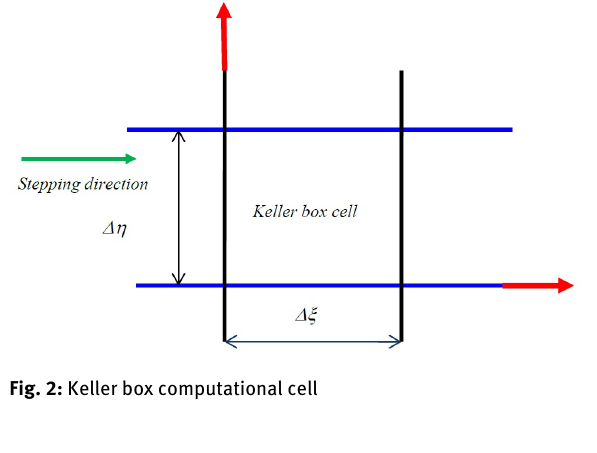
Fig. 2: Keller box computational